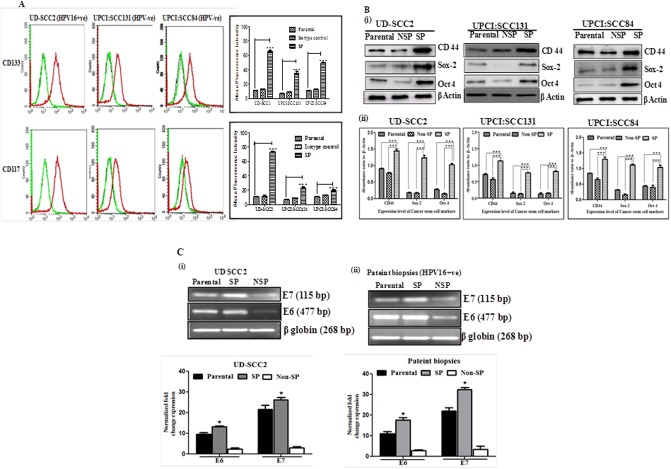
Characterization of SP cells as cancer stem cells and expression of HPV16 E6 and E7 oncoprotein.A. Flow cytometric characterization identified SP cells as Cancer stem cell in (i) UD-SCC2, (HPV16+ve), (ii) UPCI:SCC131 and (iii) UPCI: SCC 084 (HPV-ve) cell lines using CD133 and CD117 cancer stem cell markers. Sphere-forming cells or SP cells and monolayer cells or parental cells were stained with CD117 and CD133 conjugated primary antibodies and subjected to flow cytometry. Red line corresponds to sphere-forming cells, black line to monolayer cells or parental cells as negative controls and green line to isotype control. Isotype matched mouse immunoglobulins served as controls. (iv) Bar graphs adjacent to histograms in each panel show Mean Fluorescent Intensity (MFI) of the peak at the higher fluorescence in the figure. Data from one of three independent experiments are shown (n = 3). The star above the bars represents the P value. The results were analyzed by one way ANOVA followed by Tukey’s post hoc multiple comparison test. * = P ≤ 0.05; ** = P ≤ 0.01; *** = P ≤ 0.001 and **** = P ≤ 0.0001. B. OSCC express CSC markers: (i) Western blot analysis of cancer stem cell markers from protein extract of sorted SP, NSP and parental cells from UD-SCC2 HPV16+ve, UPCI:SCC131 (HPV-ve)and UPCI:SCC84 (HPV-ve) cells. A total of 25 μg protein extracts each from SP, NSP and parental cells were separated on a 10% SDS-PAGE, electrotransferred on PVDF membrane and probed. To confirm equal protein loading, the membranes were reprobed for β-actin expression. (ii) The relative normalized fold change in the protein is expressed as the mean ±SD of three independent experiments. ***P value <0.001, **P value <0.01, *P value <0.05 for UD-SCC2 HPV16+ve, UPCI:SCC131 (HPV-ve)and UPCI:SCC84 (HPV-ve) cells. C (i-ii). Representative photograph of EtBr-stained 2% agarose gel showing qRT-PCR amplification of HPV16 oncoproteins E6 and E7 in cDNA prepared from HPV16+ve SP, NSP and parental UD SCC2 cells and tumor biopsies. β globin was used as input control for normalization. i &ii (lower panel): Aggregated mean (± S.D.) abundance ratios of the transcripts w.r.t. β globin in three independent experiments. *p value ≤ 0.05 versus control NSP cells. Parental cells cultured in adherent condition were used as reference.